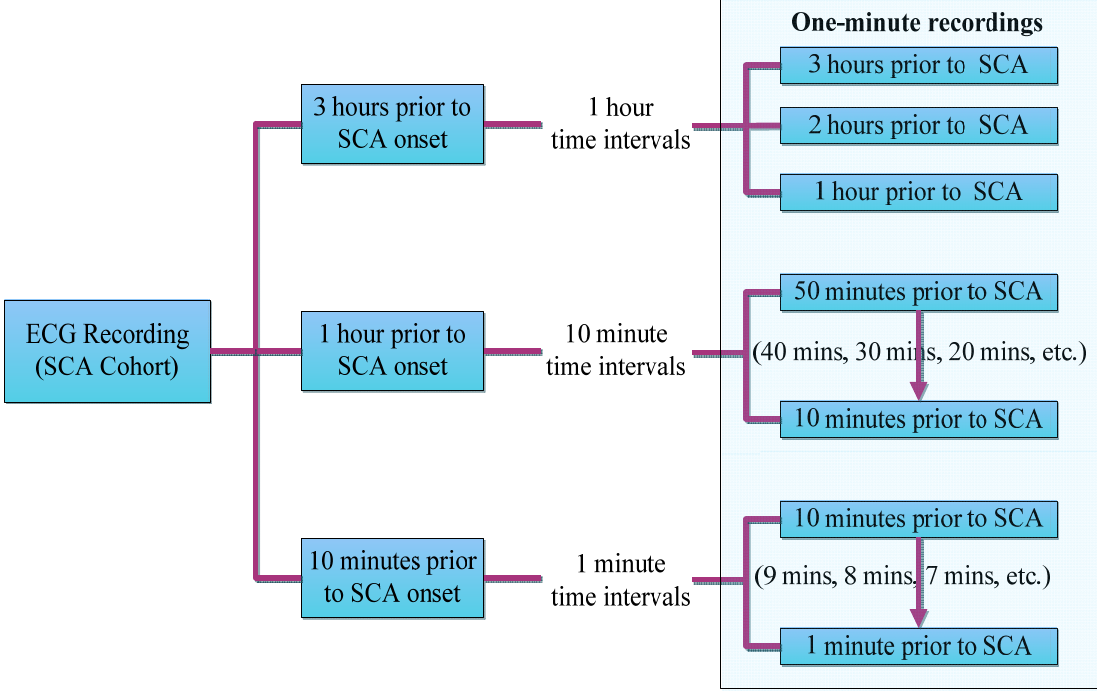
Figure 2. Block diagram of the data segmentation process for the ECG recordings obtained from the SCA cohort.